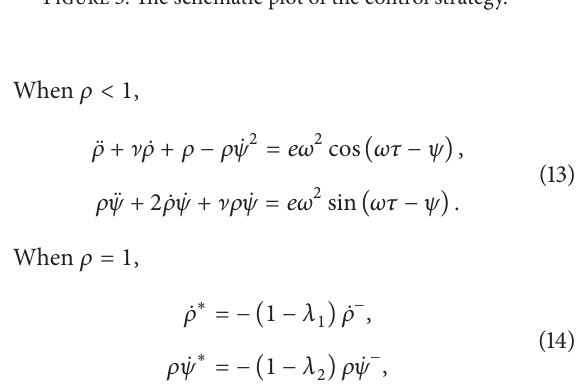
Figure 3: The schematic plot of the control